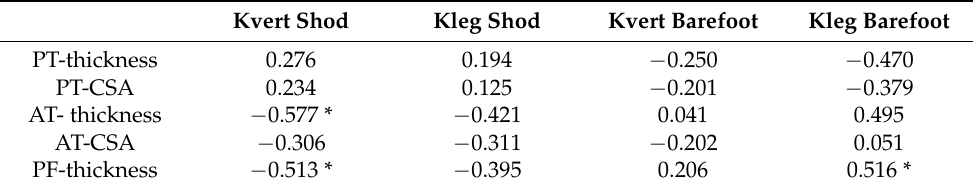
Table 1. Relationship (Pearson coefficient) between connective tissue morphology and lower- limb stiffness. Kvert Shod Kleg Shod Kvert Barefoot Kleg Barefoot PT-thickness 0.276 0.194 − 0.250 − 0.470 PT-CSA 0.234 0.125 − 0.201 − 0.379 AT- thickness − 0.577 * − 0.421 0.041 0.495 AT-CSA − 0.306 − 0.311 − 0.202 0.051 PF-thickness − 0.513 * − 0.395 0.206 0.516 * * p < 0.05; AT: Achilles’ tendon; CSA: cross-sectional area; Kleg: leg stiffness; Kvert: vertical stiffness; PT: patellar tendon; PF: plantar fascia.